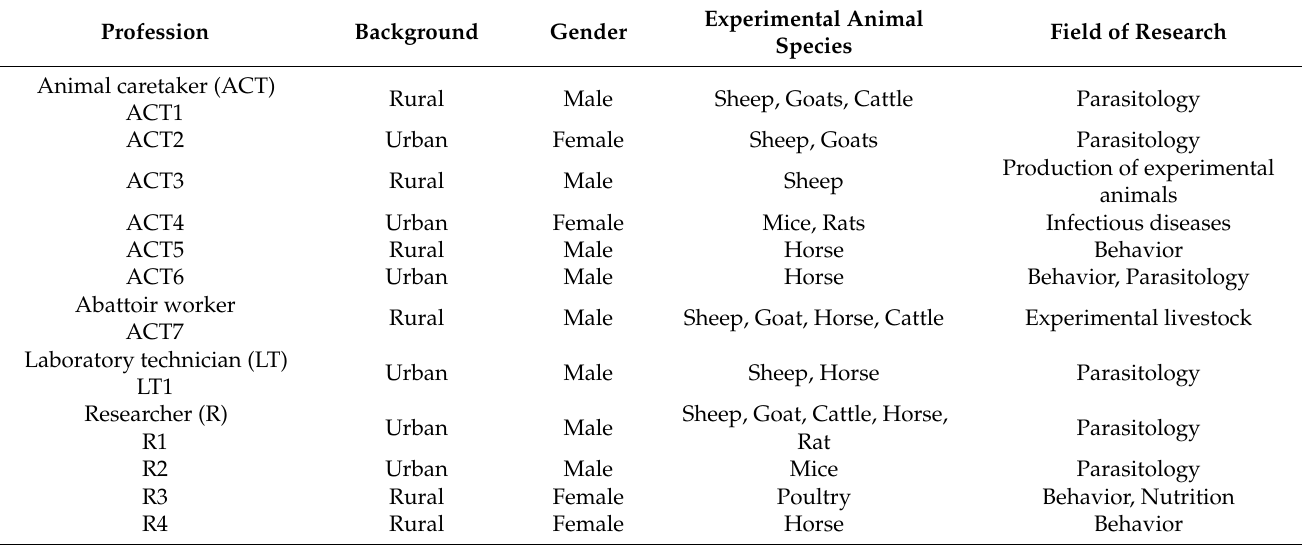
Table 1. Characteristics of the stakeholders in animal research that were